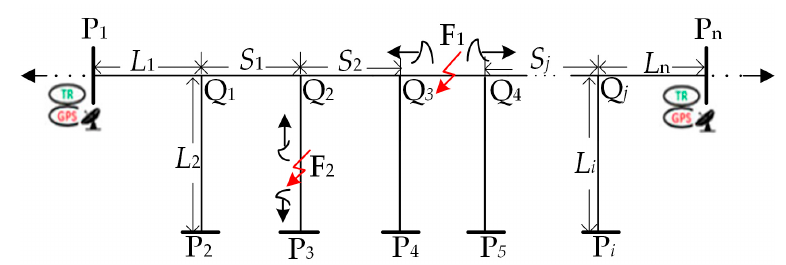
Figure 3. Multi-terminal line model monitored at two terminals.